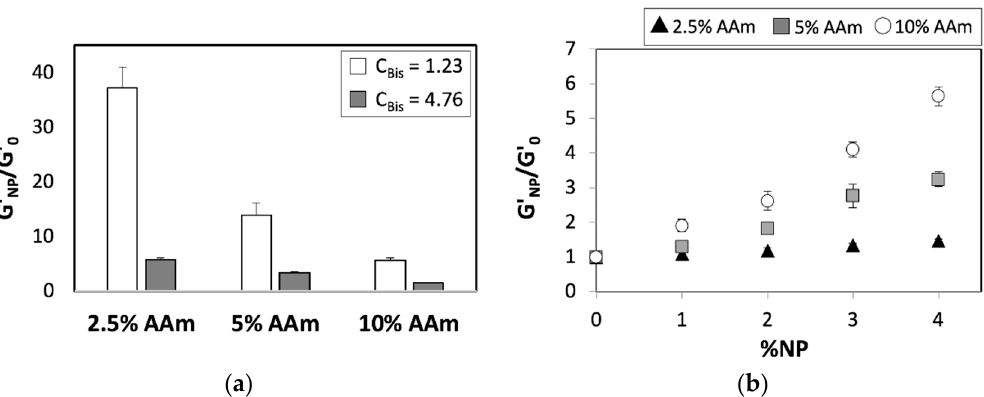
Figure 3. Relative elastic moduli of pAAm hydrogels as a function of ( a ) monomer concentration (%AAm) prepared using 5% 4 nm SiNPs and different concentrations of the chemical crosslinker— 0.0625% Bis (white bars) and 0.5% Bis (grey bars) and ( b ) nanoparticle concentration for 2.5% pAAm (white circles), 5% pAAm (grey squares), and 10% pAAm (black triangles) hydrogels prepared using % C Bis = 4.76. Data shown are the mean of triplicate measurements ± standard deviation and have been repeated at least three times with similar results.